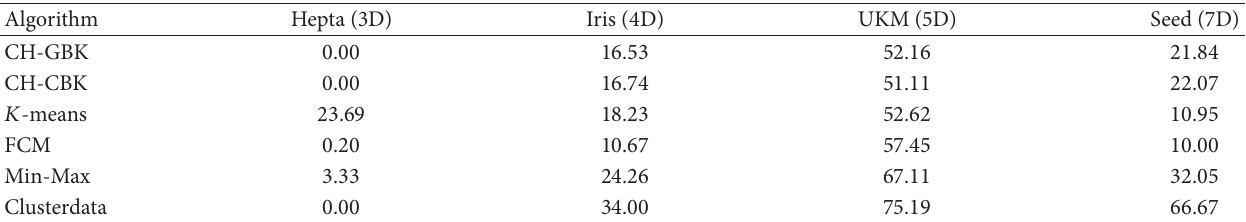
Table 1: Mean error rate (%) of pattern assignments averaged over 100 different runs of the algorithms.